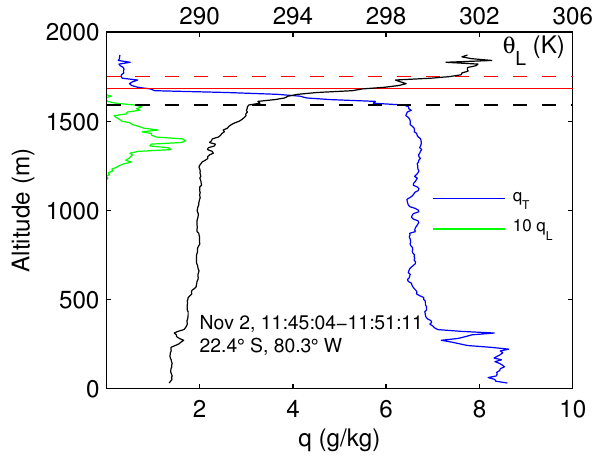
Fig. 11. Liquid water mixing ratio (green), total water mixing ra- tio (blue), and liquid potential temperature (black) profiles illustrat- ing the inversion structure observed in a typical POC profile. The dashed black line marks the inversion base. The inversion top de- duced using the criteria described in Sect. 3.1 is indicated by the solid red horizontal line, whereas the visually determined inversion top used to calculate κ is indicated by the dashed red line.